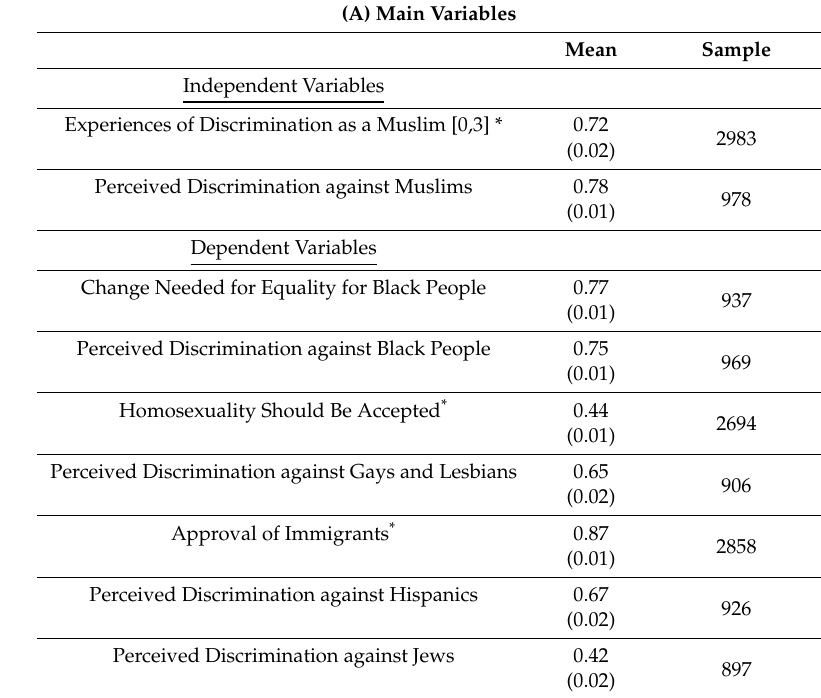
Table 1. ( A ) Means and Standard Errors of Main Variables. ( B ) Means and Standard Errors of